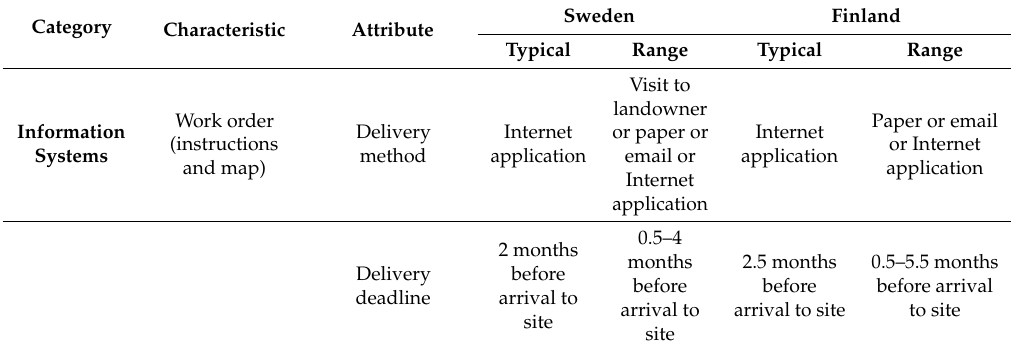
Table 4. Organizational characteristics of mechanized tree planting in 2017 in Sweden and Finland (pl =